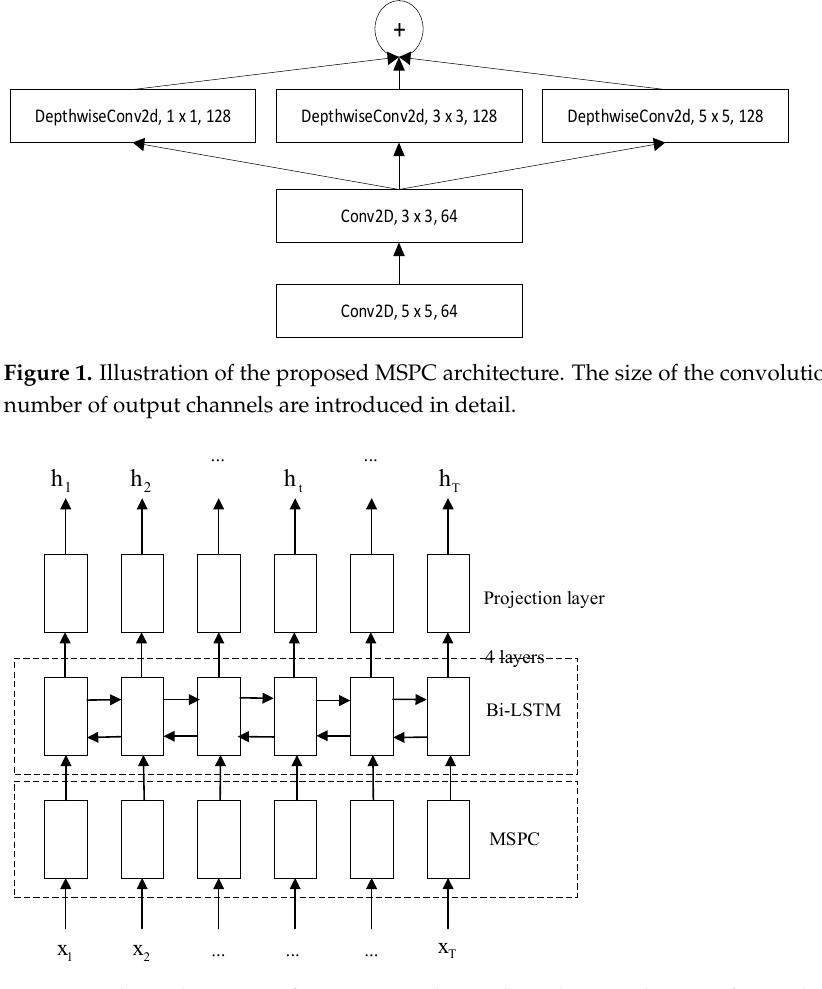
Figure 2. The architecture of our proposed encoder. The encoder transforms the input sequence 𝑋 (cid:2869) , 𝑋 (cid:2870) , …, 𝑋 (cid:3021) into the corresponding hidden state ℎ (cid:2869) , ℎ (cid:2870) , … , ℎ (cid:3021) . Among them, the input sequence is a three-dimensional matrix (batch, time, feats).